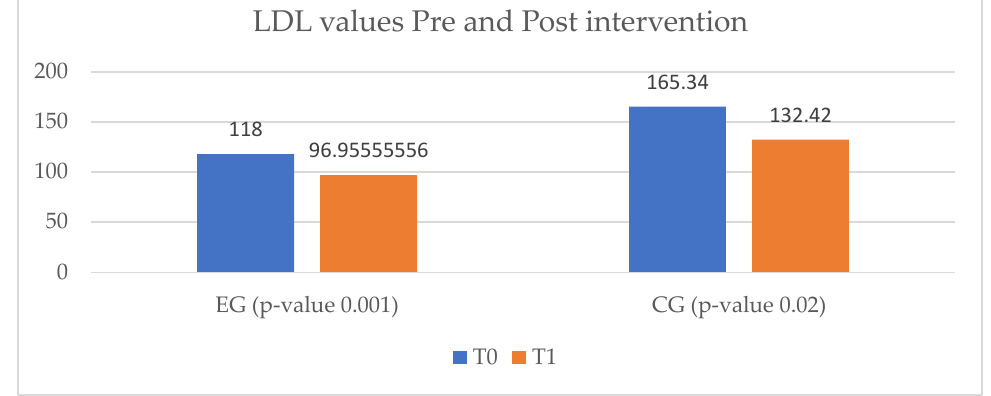
Figure 8. LDL-cholesterol values in the ischemic heart disease study group. EG = experimental group; CG = control group; T 0 = before the rehabilitation period; T 1 = after the rehabilitation period .